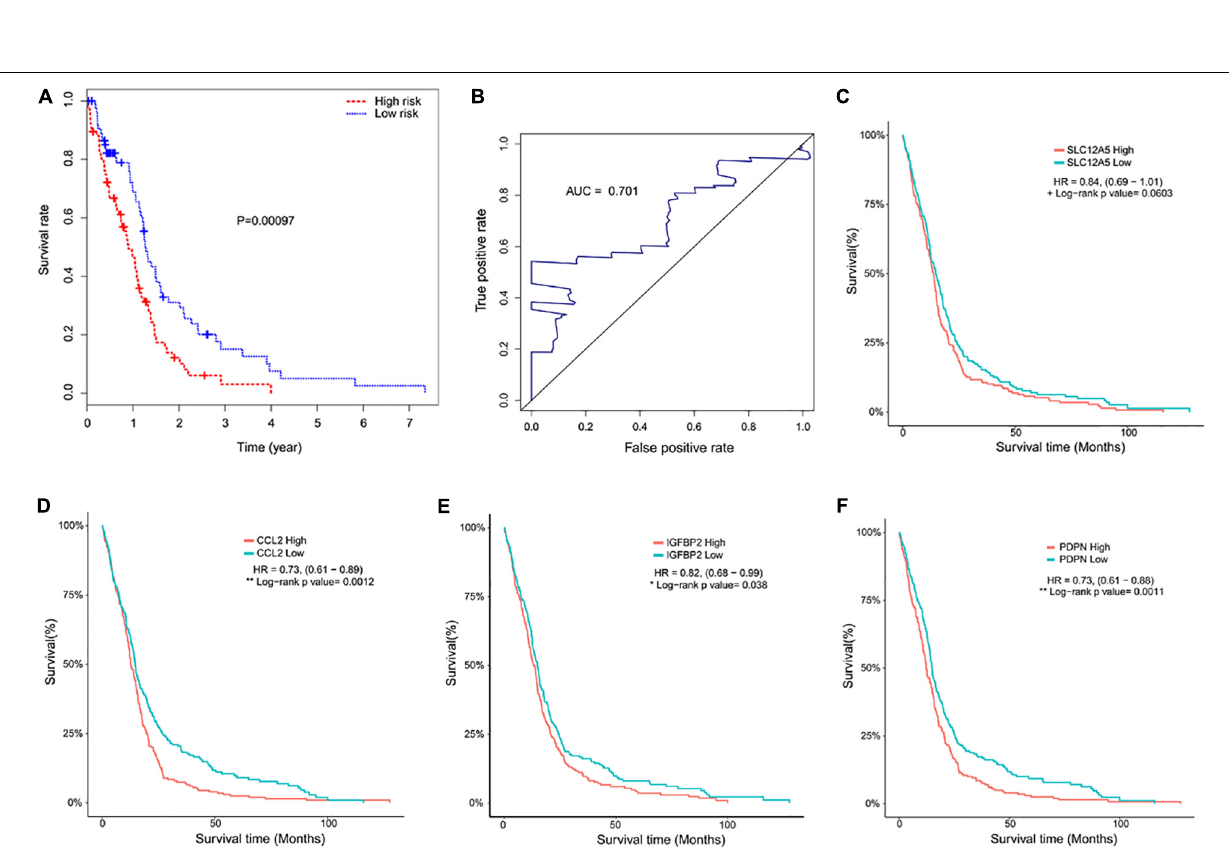
FIGURE 6 | Kaplan–Meier curves and receiver operating characteristic (ROC). (A) Kaplan–Meier curve showed that the mortality in the high-risk group was higher than that in the low risk group ( P < 0.001). (B) Time-dependent ROC curve indicated a higher predictive value. The area under the ROC curve (AUC) was 0.701. (C–F) Kaplan–Meier curves of the four predictive